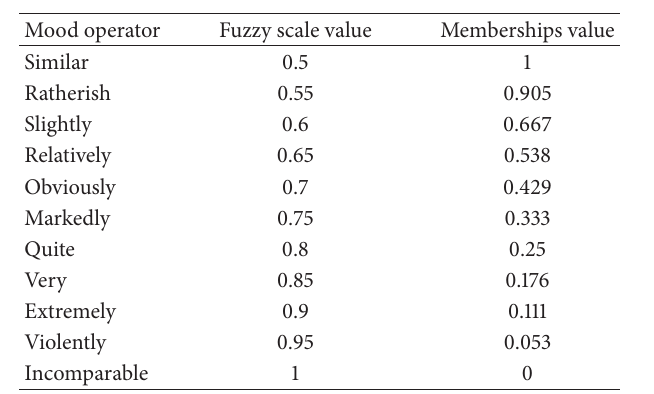
Table 1: Relationships between mood operator and fuzzy value.